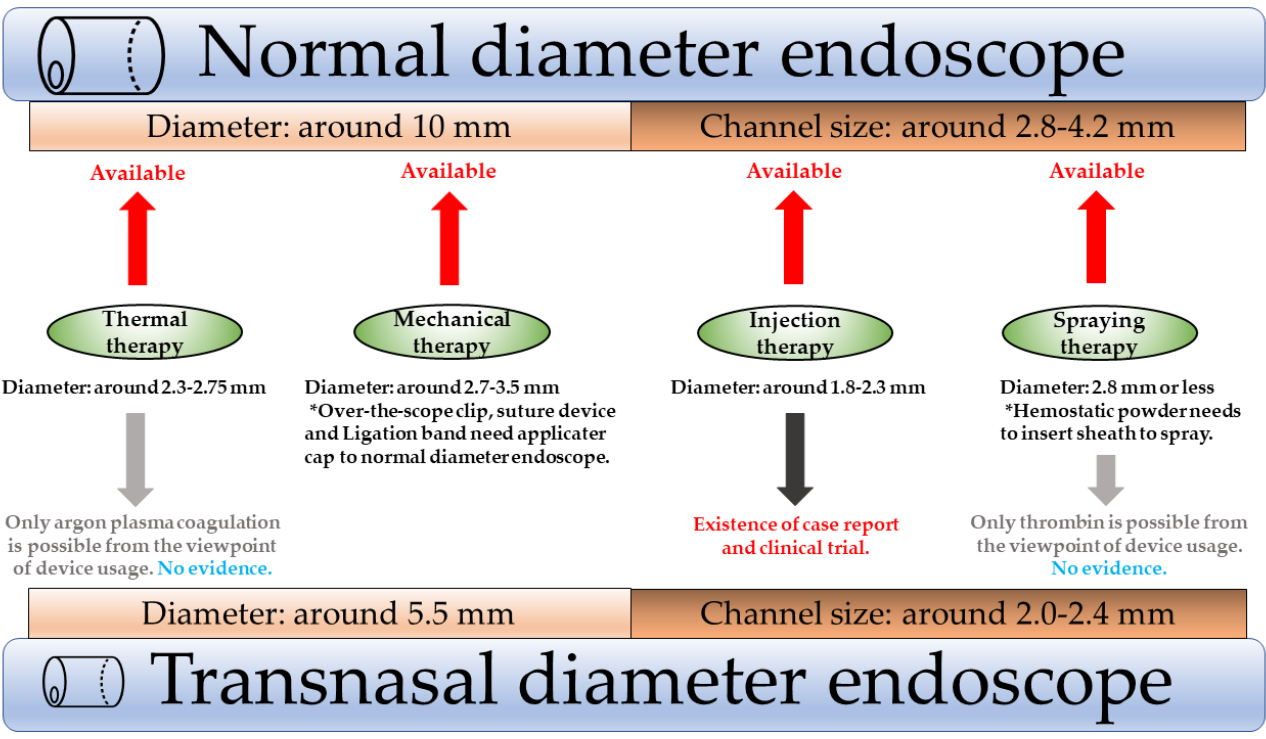
Figure 1. Adaption of hemostatic devices in normal and TNE.